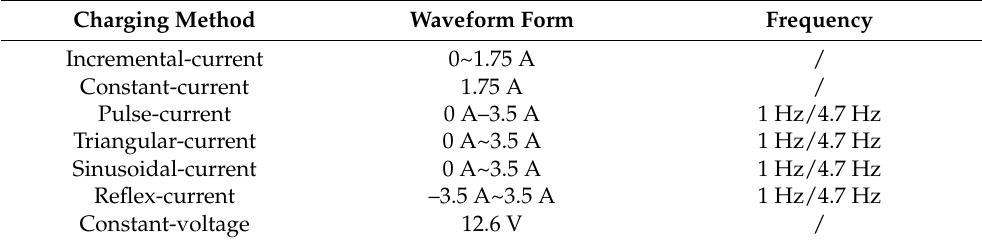
Table 3. Waveform setup of five charging